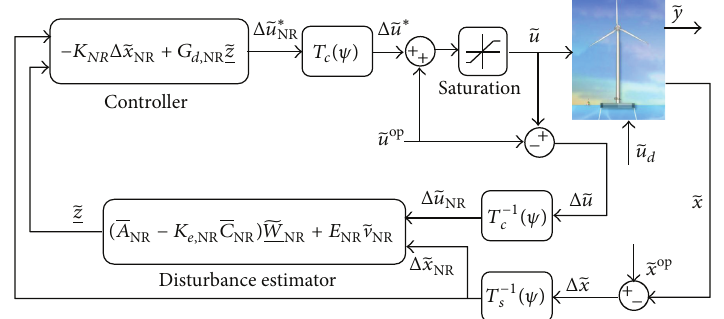
Figure 2: SSFC with DAC implementation for offshore wind